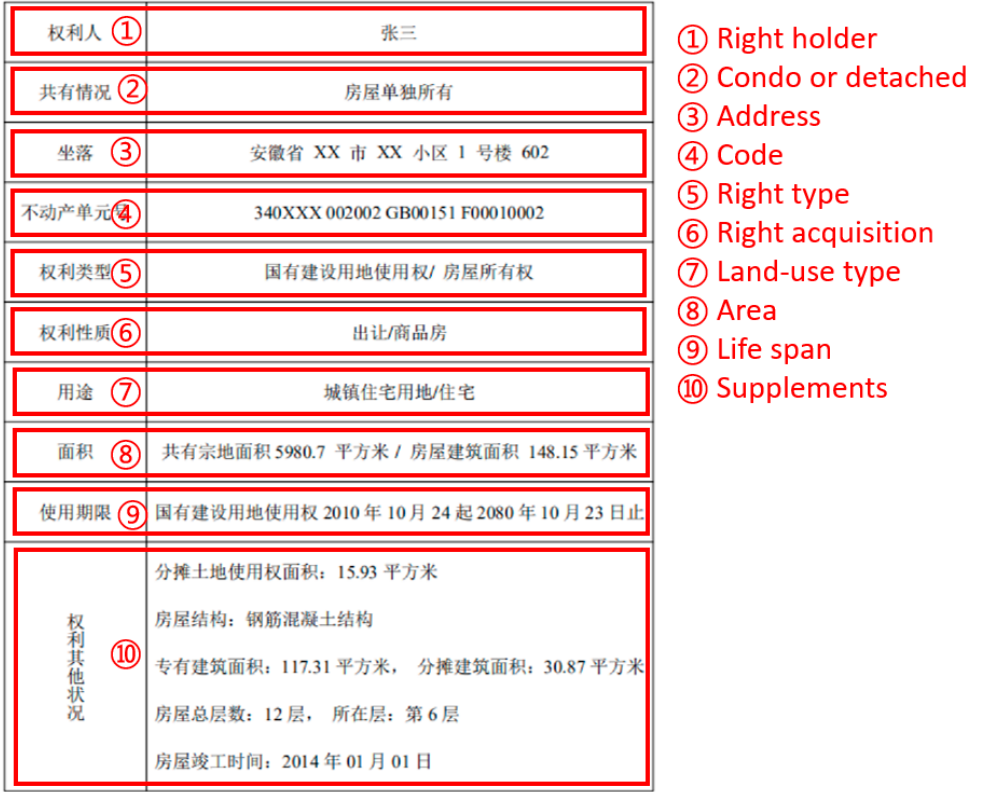
Figure 5. Ownership certificate of an estate building (source: http://news.focus.cn/zh/2015-03-07/6090778.html , 26 Octo- ber 2021 ).